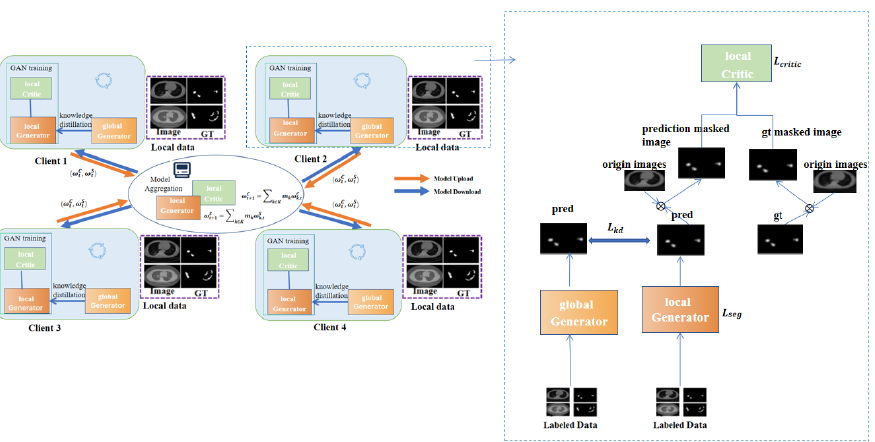
Figure 2. An overview of the privacy-preserving generative adversarial network framework (MixFedGAN) that deals with COVID-19 CT data from four regions using federated